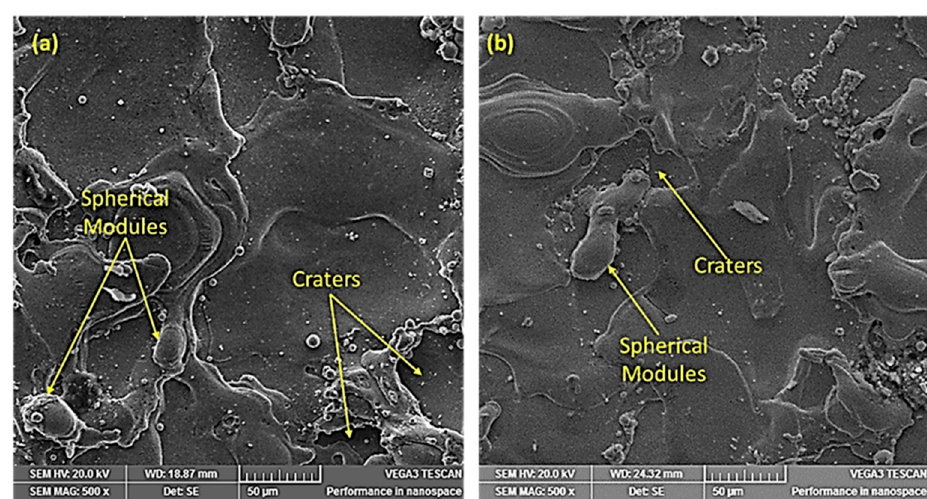
Figure 6. SEM micrograph of machined samples at: ( a ) 4 A, 50 V, 45 Hz, and 240 mm; and ( b ) 1 A, 80 V, 45 Hz, and 220 mm.